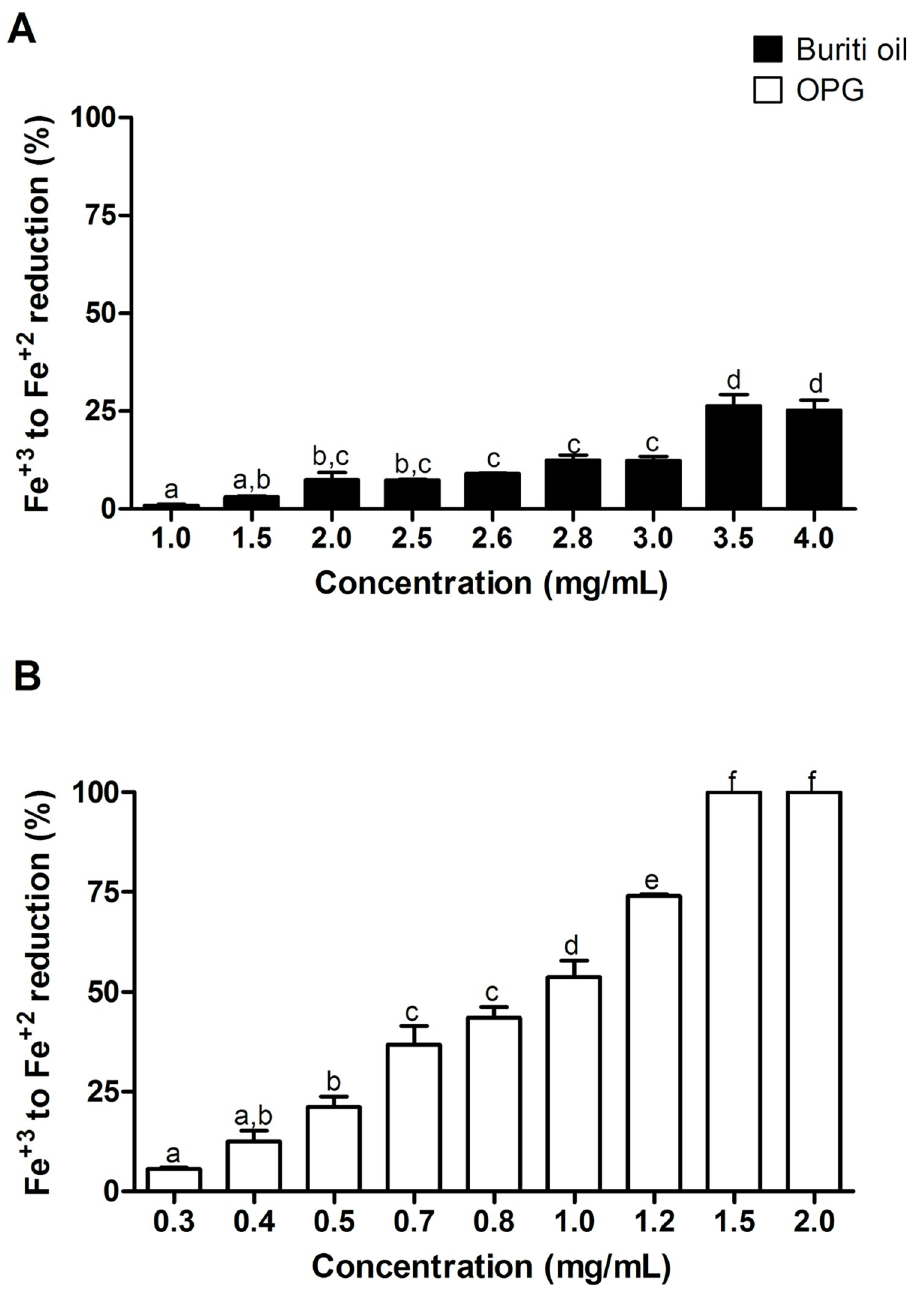
Fig 5. Reducing power test of crude buriti oil (A) and OPG nanoformulation. The data obtained presented parametric distribution. Therefore, the ANOVA test with Tukey’s post-test was used to determine the significant differences. � Equal letters indicate that the values do not differ statistically (p >